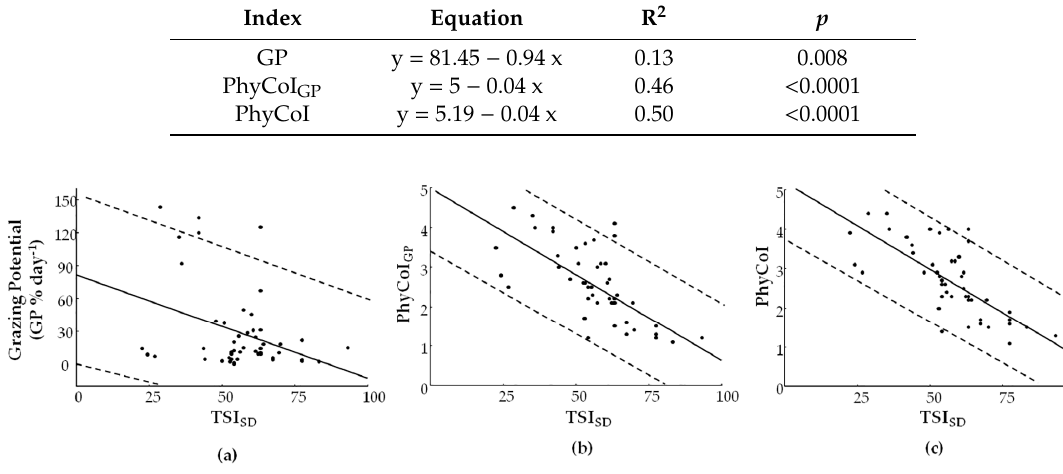
Figure 5. Scatter diagram of the ( a ) GP, ( b ) PhyCoI GP and ( c ) PhyCoI index compared to trophic state index (TSI SD ) for the studied lakes (n = 54). The solid line indicates the linear regression line. The dashed lines indicate the (95%) prediction limits of the model.